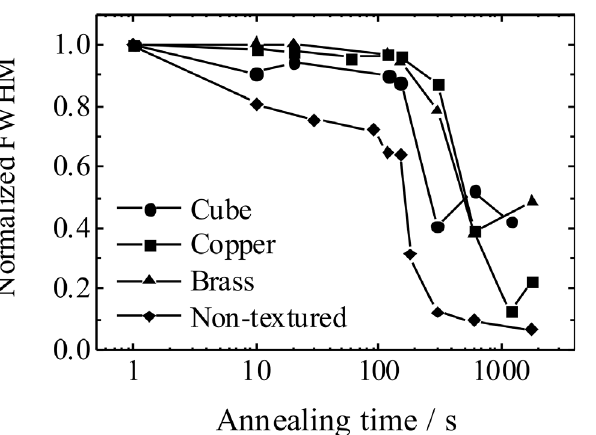
Figure 12: Variation in FWHMs of the 200-reflection profiles for texture and non-texture components of the annealed 75% cold-rolled copper sheets as a function of the annealing